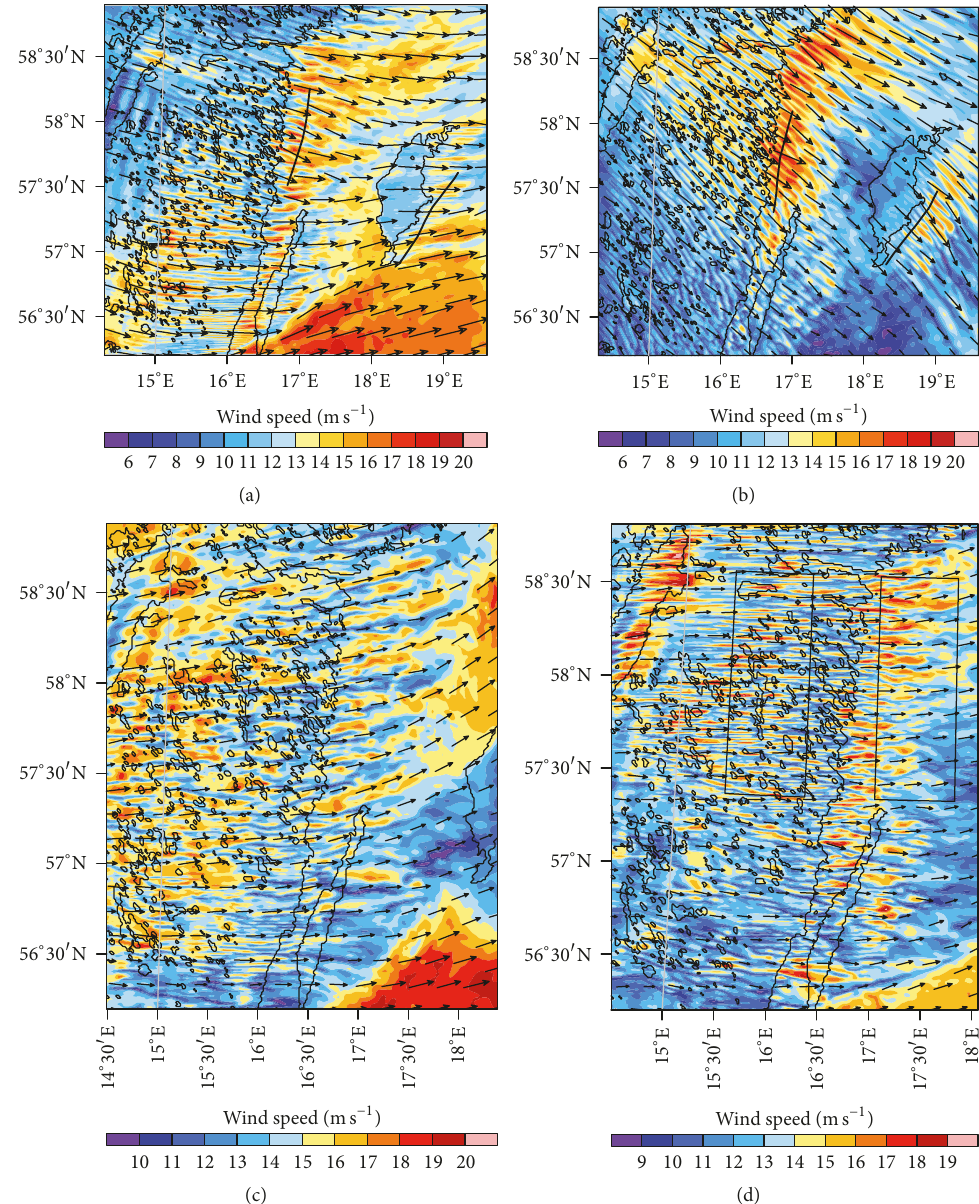
Figure 5: Wind speed from WRF simulations at 100m height at (a) 2 May 1997, 1100UTC, (b) 3 May 1997, 1100UTC, (c) 17 May, 1600UTC, and (d) 25 May, 13UTC. The black lines in (a) and (b) show the location of the flight legs from these days. The black rectangles in (d) show the study areas over land and